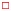
Changes in diffusion properties in the caudate-putamen during hydrocephalus development.Diffusion properties showed that the mean diffusivity of the (a) caudate-putamen and (c) dorsal internal capsule was similar in hydrocephalic rats (□) and controls (□). On the other hand, (b) the fractional anisotropy in caudate-putamen was significantly higher from day seven and (d) the dorsal internal capsule was significantly higher from day three in hydrocephalic rats (□) and controls (□). P values for significance of the interaction between groups in the RM ANOVA tests and significant Sidak’s comparisons are reported for each graph.